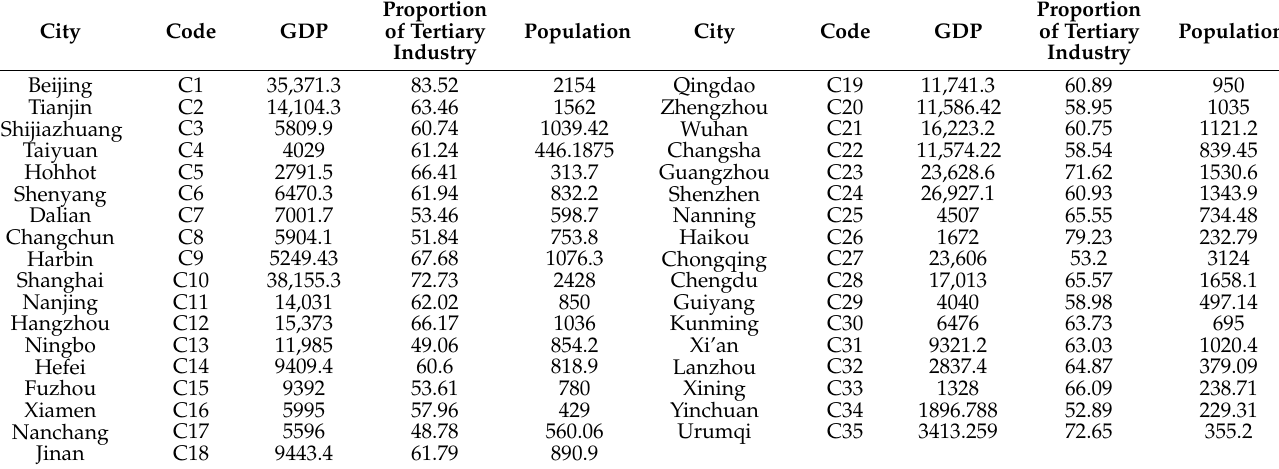
Table A1. Social-Economic Information of Sample Cities in This